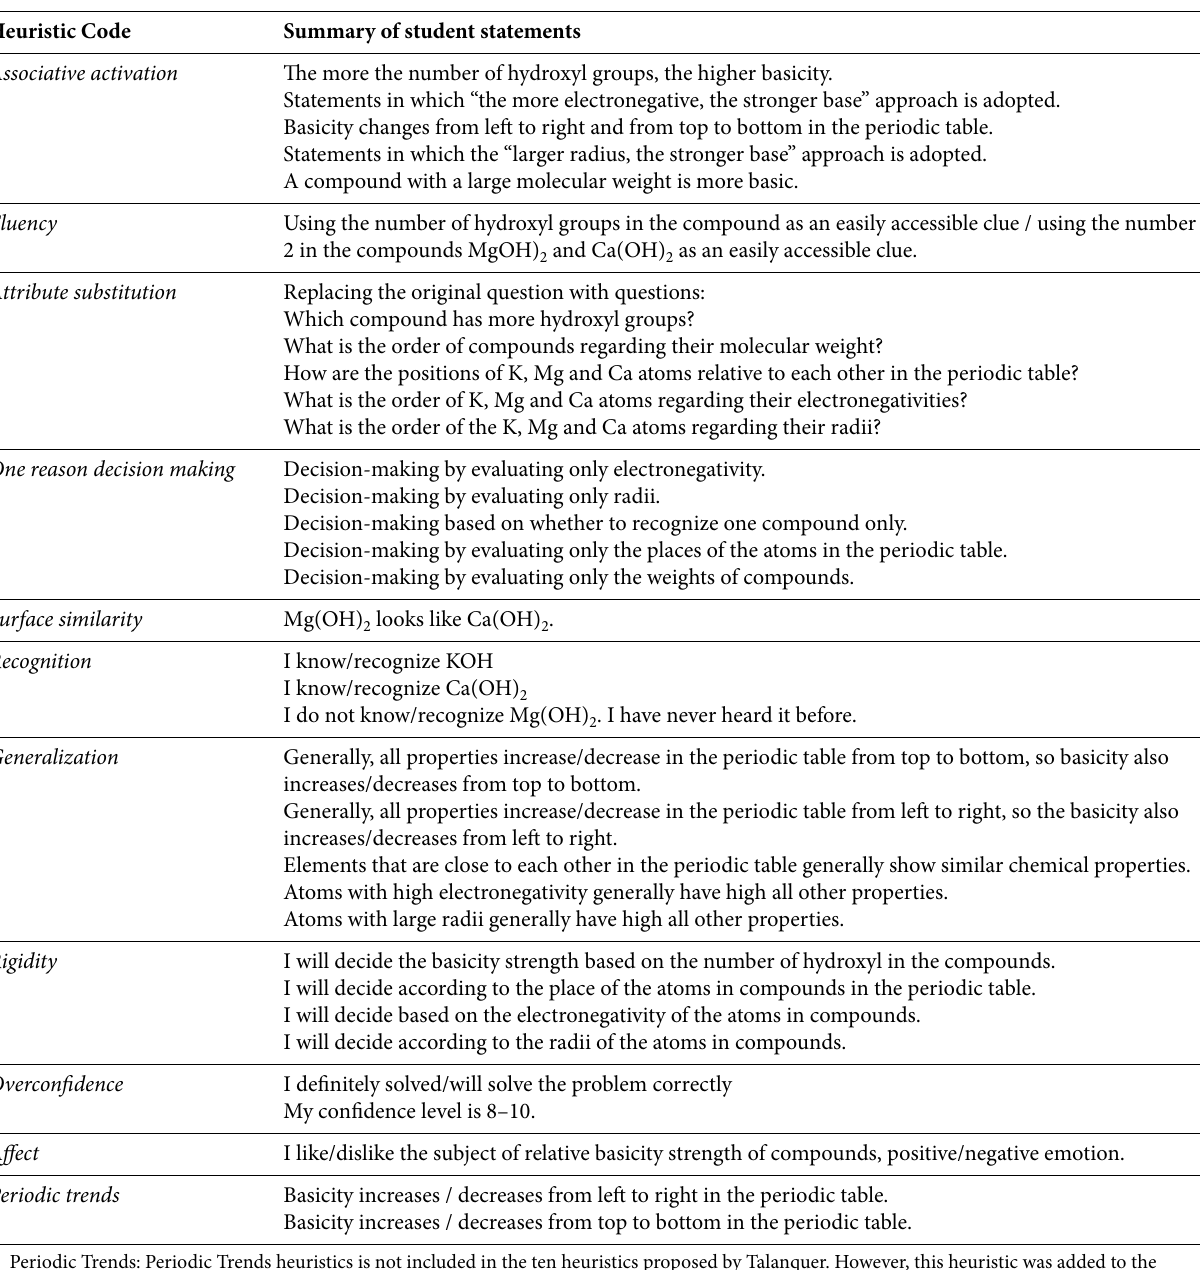
Table 4. Student Expressions Related to Heuristics (Basicity strength, KOH, Mg(OH) 2 and Ca(OH) 2